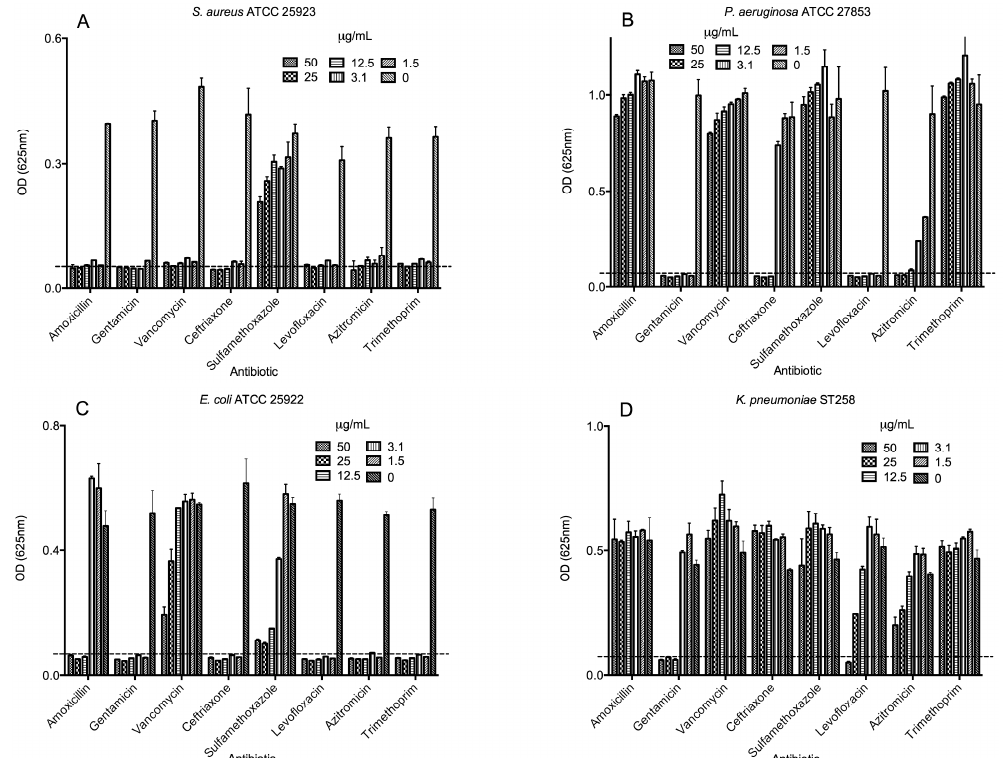
Figure 3. Dose-response activities of selected antibiotics against bacteria. The eight commercial antibiotics were tested against the growth of ( A ) Staphylococcus aureus ATCC 25923; ( B ) Pseudomonas aeruginosa ATCC 27853; ( C ) Escherichia coli ATCC 25922; and ( D ) Klebsiella pneumoniae ST258 in Muller-Hinton broth. Bacteria-free well absorbances are indicated by a dotted line.